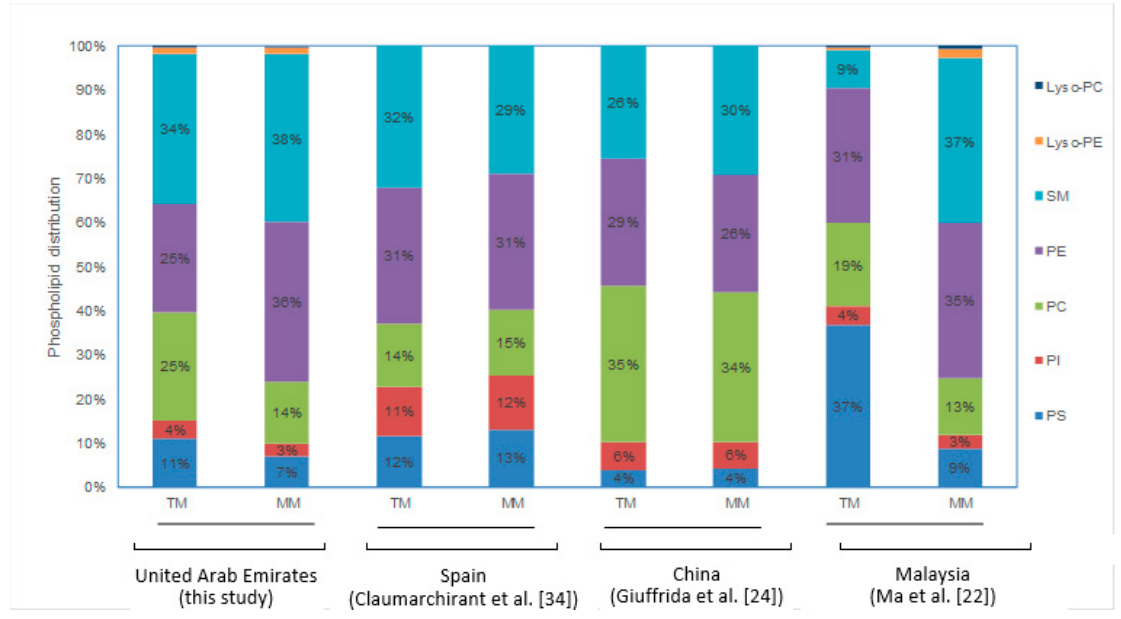
Figure 2. Distribution of phospholipid classes in transitional milk (TM) and mature milk (MM; six months post-partum) in UAE mothers’ milk, and from other geographic cohorts. SM, sphingomyelins; PC, phosphatidyl choline (PC); L-PC, PC lyso species; PE, phosphatidyl ethanolamine; L-PE, PE lyso species; PI, phosphatidyl inositol; PS, phosphatidyl serine.